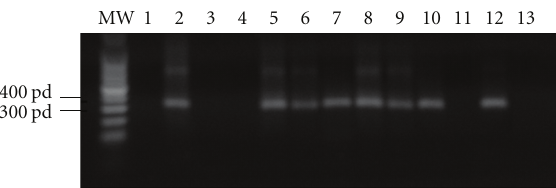
Figure 1: Detection of T. cruzi in mother, newborn, and placenta by PCR : A 330-base pair fragment of the T. cruzi satellite DNA was amplified as described in Material and Methods. MW: molecular marker, lane 1: Negative control without DNA; lane 2: DNA from T. cruzi epimastigotes; lane 3: noninfected human blood DNA; lane 4 non-infected human placenta DNA; lanes 5–7: parasite DNA detected in peripheral blood (lane 5), in placenta (lane 6), and respective umbilical chord from neonate (lane 7) of mother 1; lanes 8–10: parasite DNA detected in peripheral blood (lane 8), in placenta (lane 9), and respective umbilical cord from neonate (lane 10) of mother 2; lanes 11–13: parasite DNA detected in peripheral blood (lane 11), in placenta (lane 12) and respective umbilical chord from neonate (lane 13) of mother 3. Note that in mother 3 parasite DNA can only be detected in the placenta. The PCR product was subjected to electrophoresis in 1.6% agarose gels and stained with ethidium bromide. PCR markers from Promega were employed as molecular weight